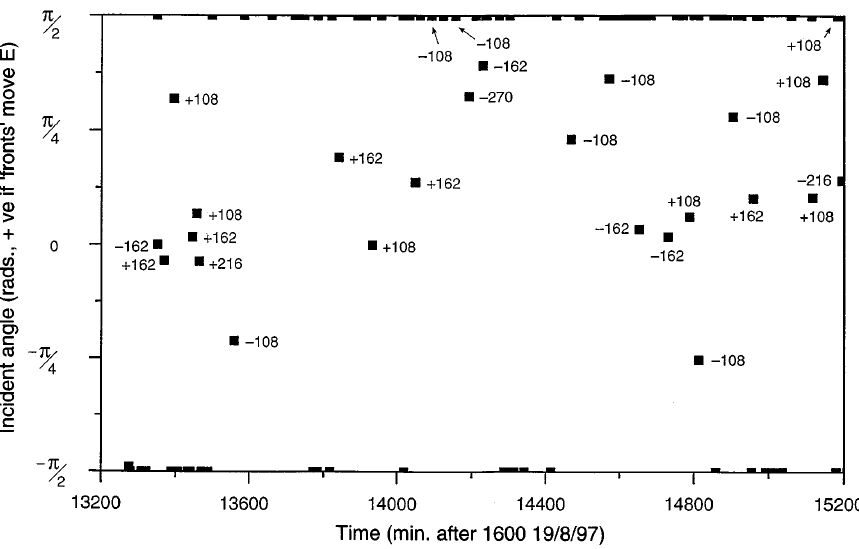
Fig. 8. The maximum angle of inci- dence of features (e.g. waves) producing events moving along the slope. The numbers indicate the event distance along the slope (m) and the sign denotes that of the temperature derivative as- sociated with